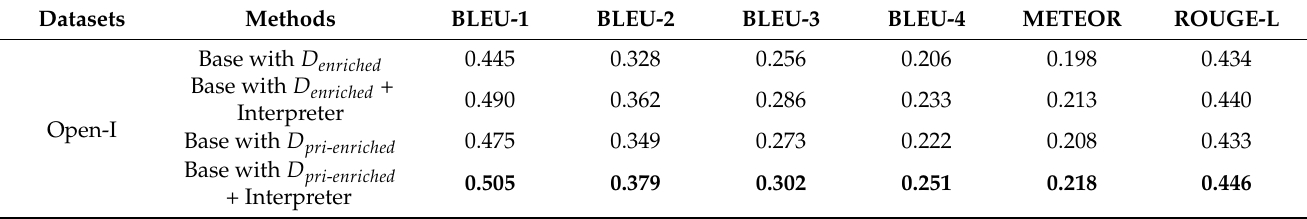
Table 3. Ablation studies. Base with D enriched refers to the model composed of the classifier